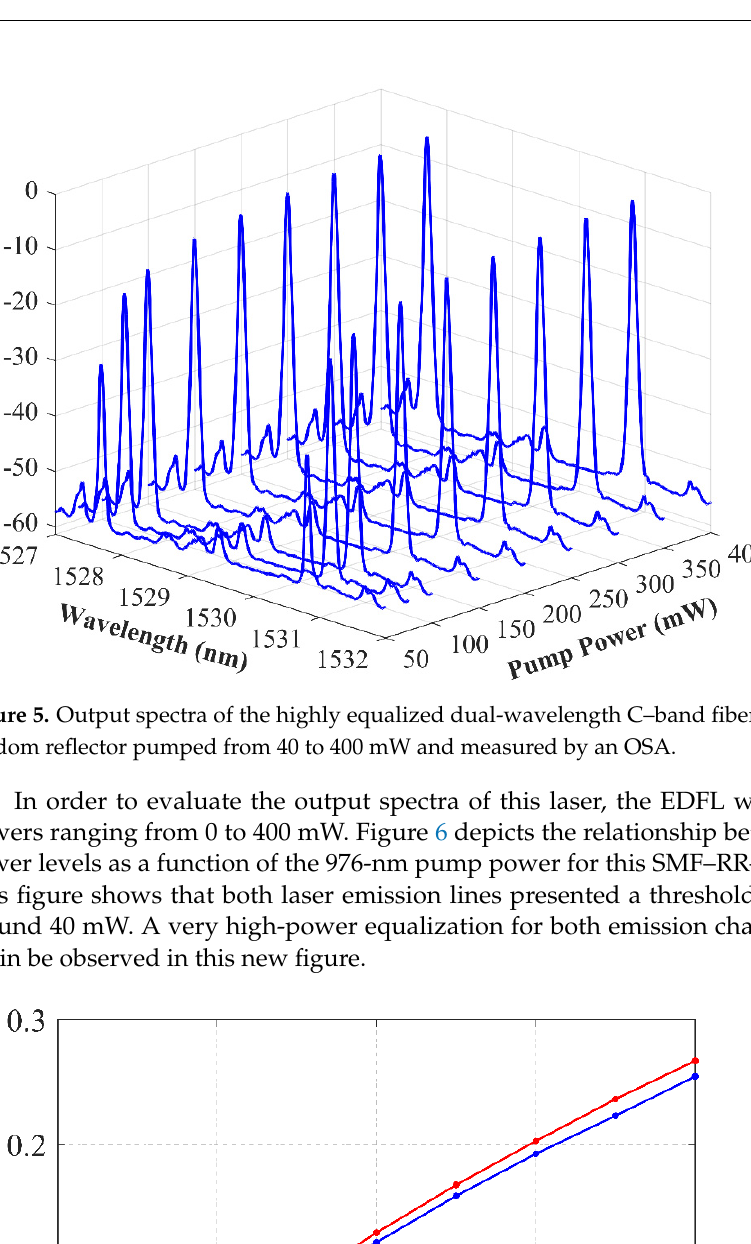
Figure 4. Output spectra of the highly equalized dual-wavelength C–band fiber laser assisted by a random reflector pumped at 150 mW and measured by an OSA.